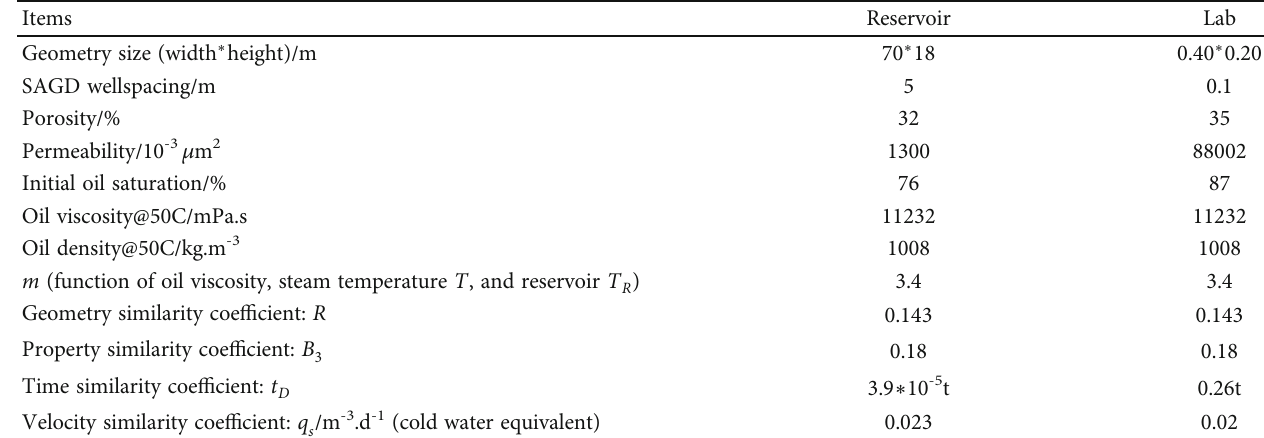
Table 1: Design results of the reservoir and the 2-D physical